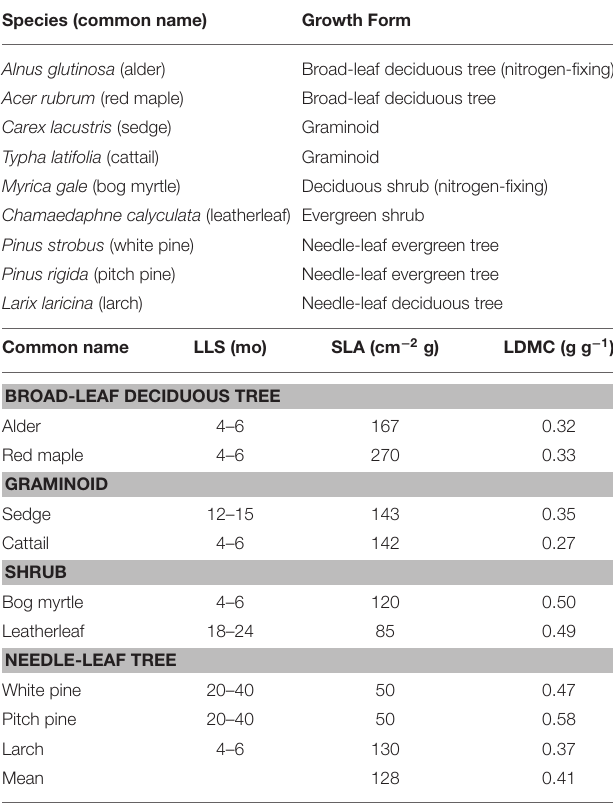
TABLE 1 | Plant species, growth form, and traits of green